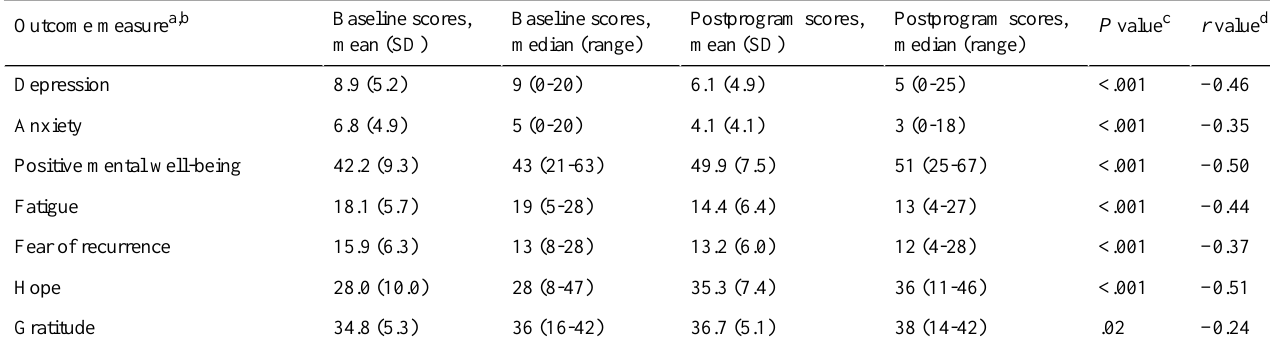
Table 3. Baseline and postprogram outcome scores